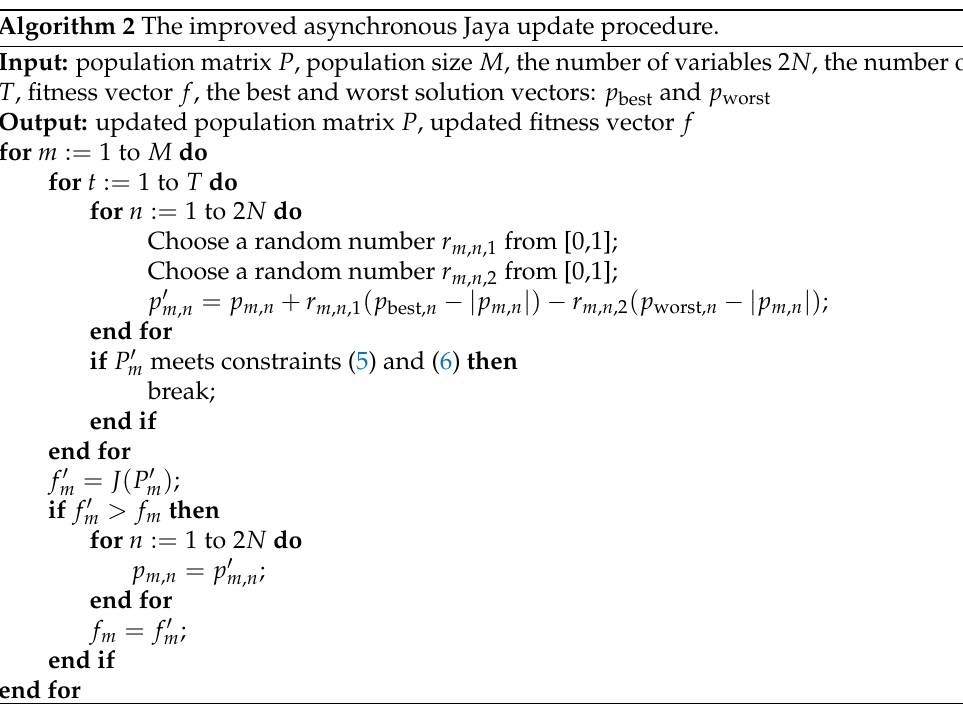
Algorithm 2 The improved asynchronous Jaya update